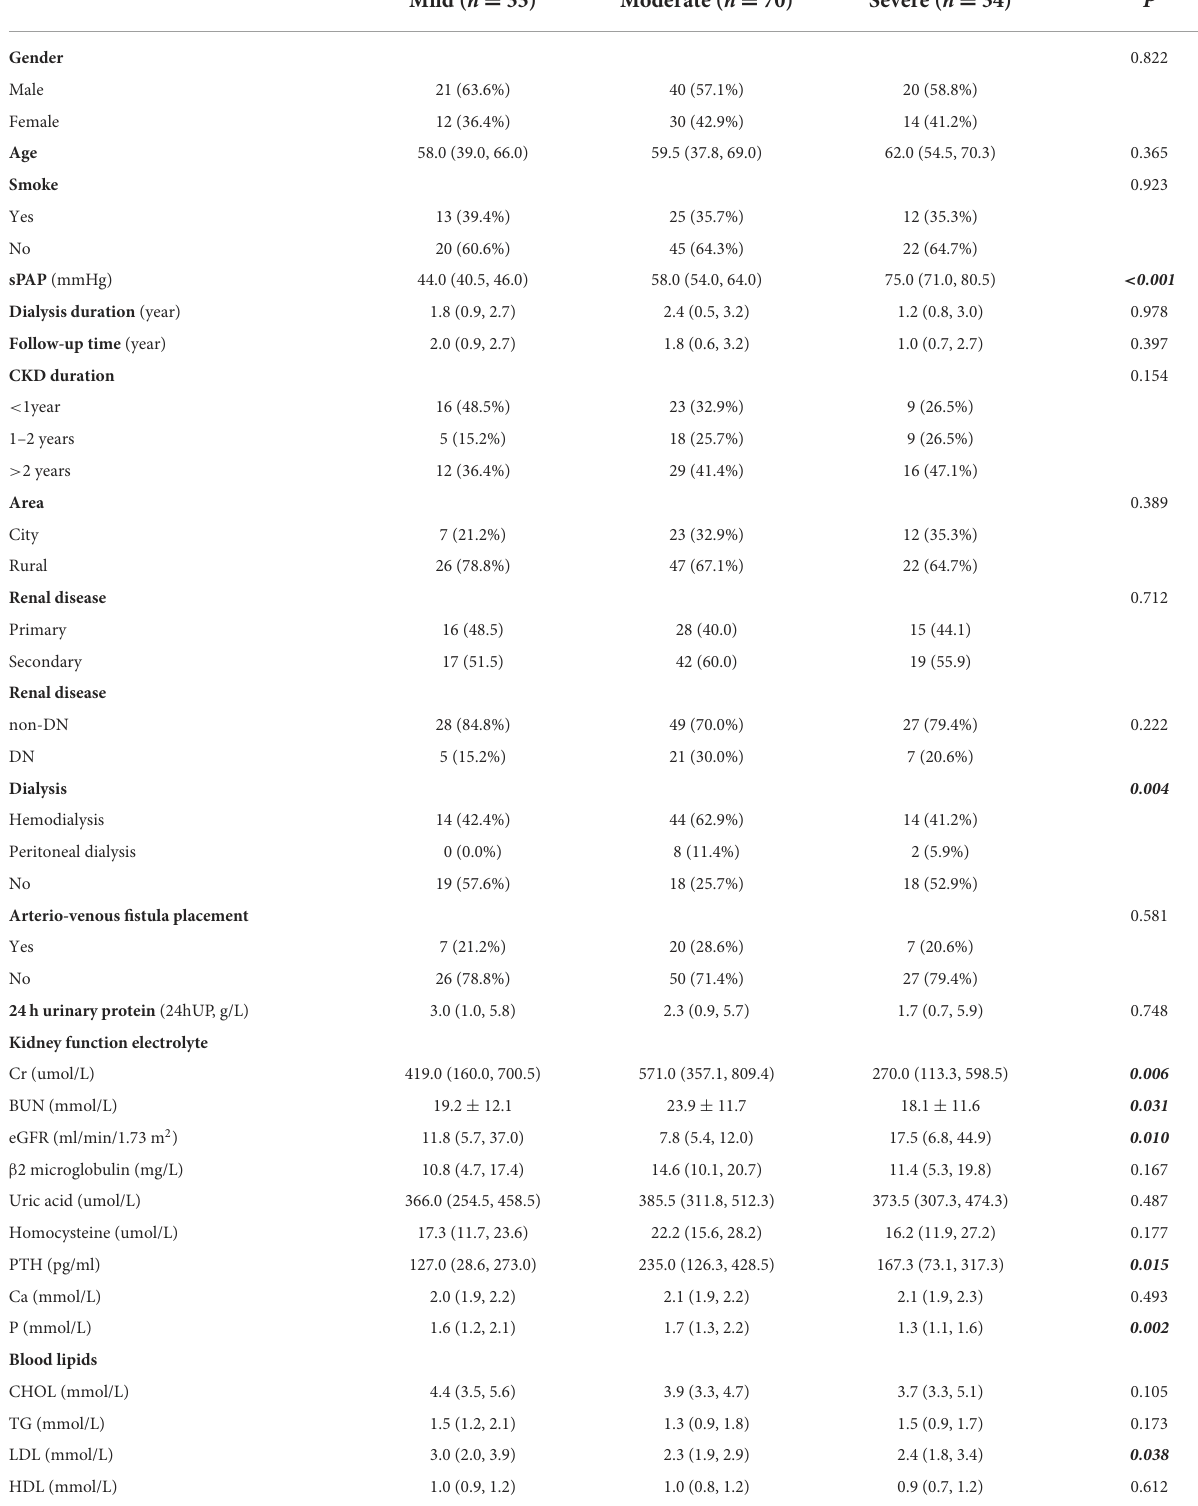
TABLE 3 Clinical characteristics of CKD with PH